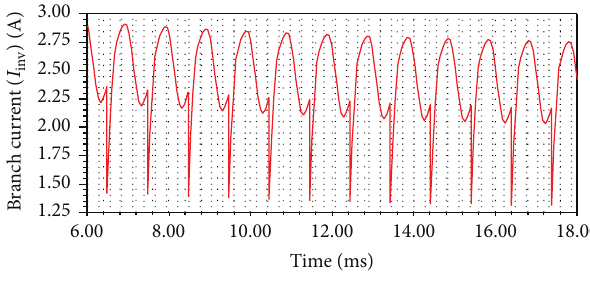
Figure 11: The leakage current (with LCL filter).